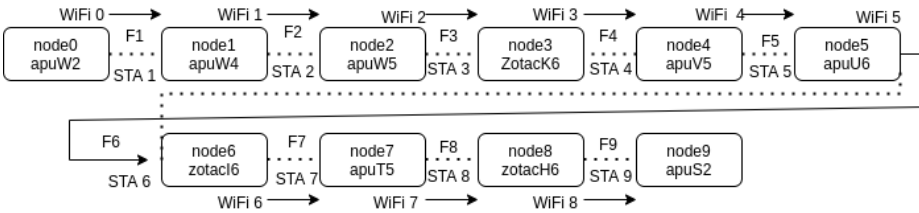
Figure 10. W-iLab2.t linear topology node